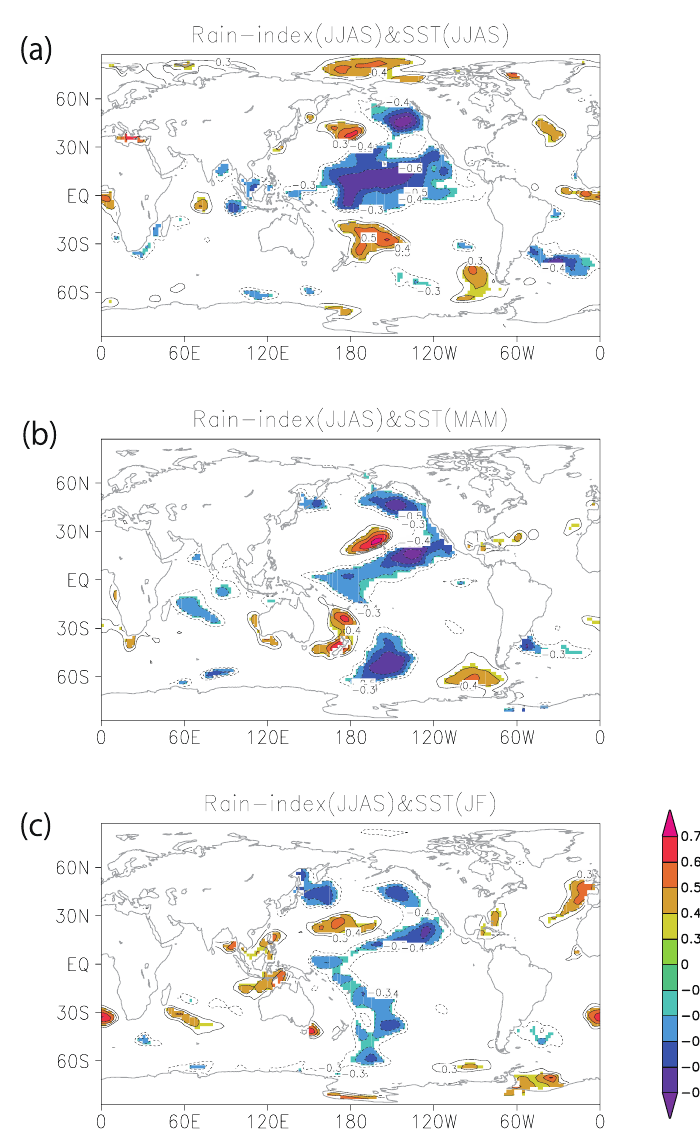
Figure 2. Climate precursors of north India summer monsoon rainfall. Correlation map between June–September (JJAS) rainfall variability over northern India (20–30° N, 75–90° E) and ( a ) same season JJAS SST anomaly, ( b ) one-season lead March–May (MAM) SST anomaly, ( c ) two-season lead January–February (JF) SST anomaly, and ( d ) same-season JJAS rainfall anomaly. In all panels, only areas above 90% significance are shown.